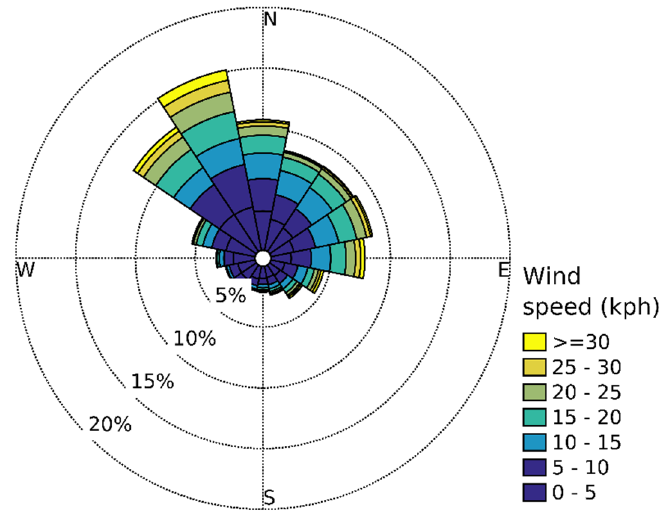
Figure A1. Sampled wind direction and wind intensity distribution used as input in FUNC-SIM.